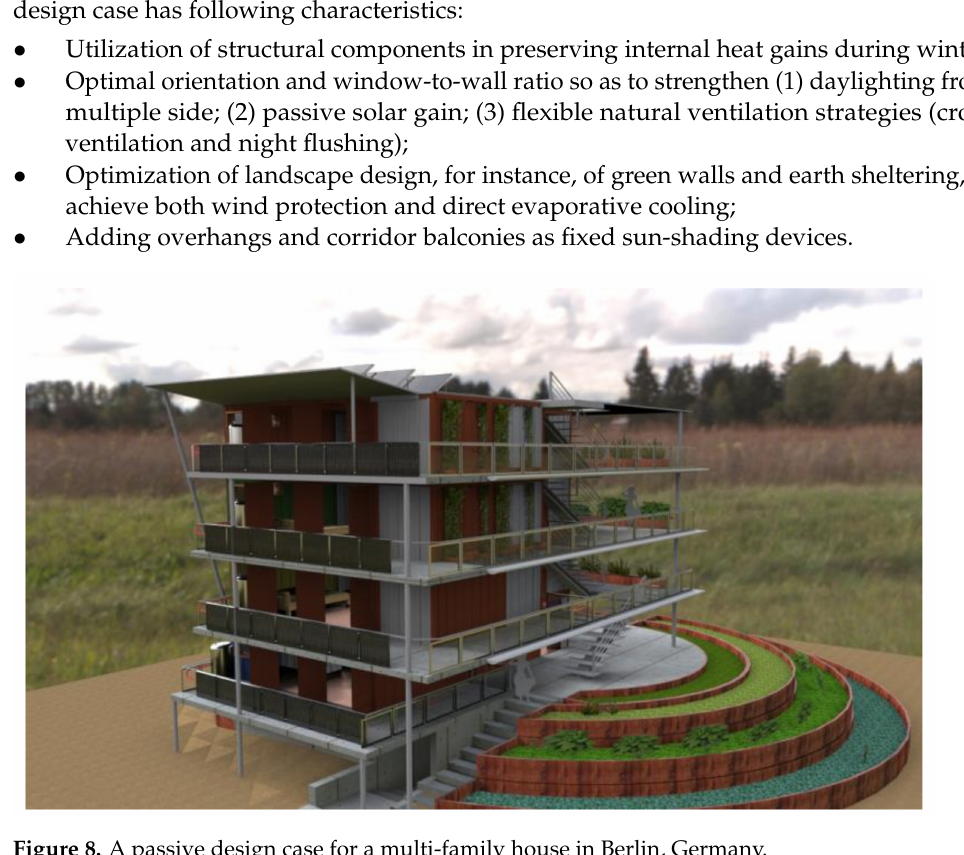
Figure 8. A passive design case for a multi-family house in Berlin,